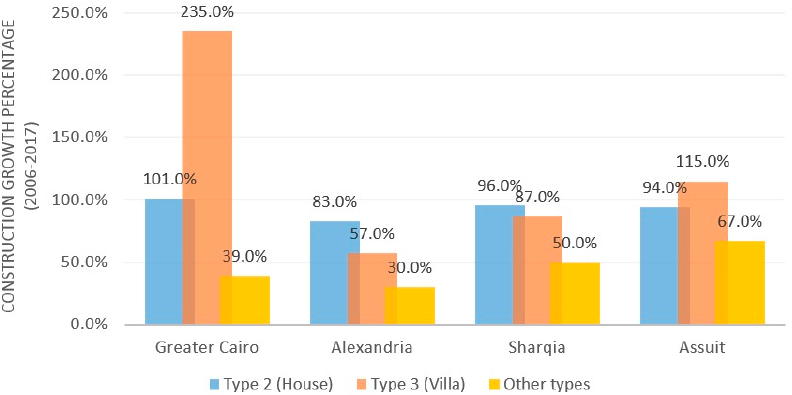
Figure 2. The growth rate of buildings in the past decade in 4 different cities based on data from [14,15].